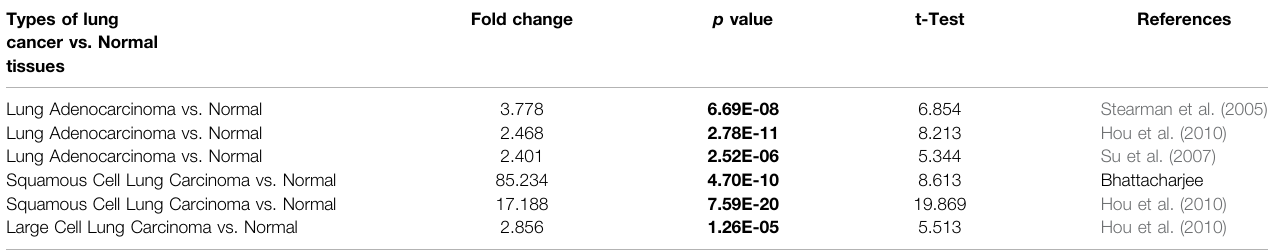
TABLE1 | The expression of SLC6A8 in subtypes of lung cancer. Types of lung cancer vs. Normal